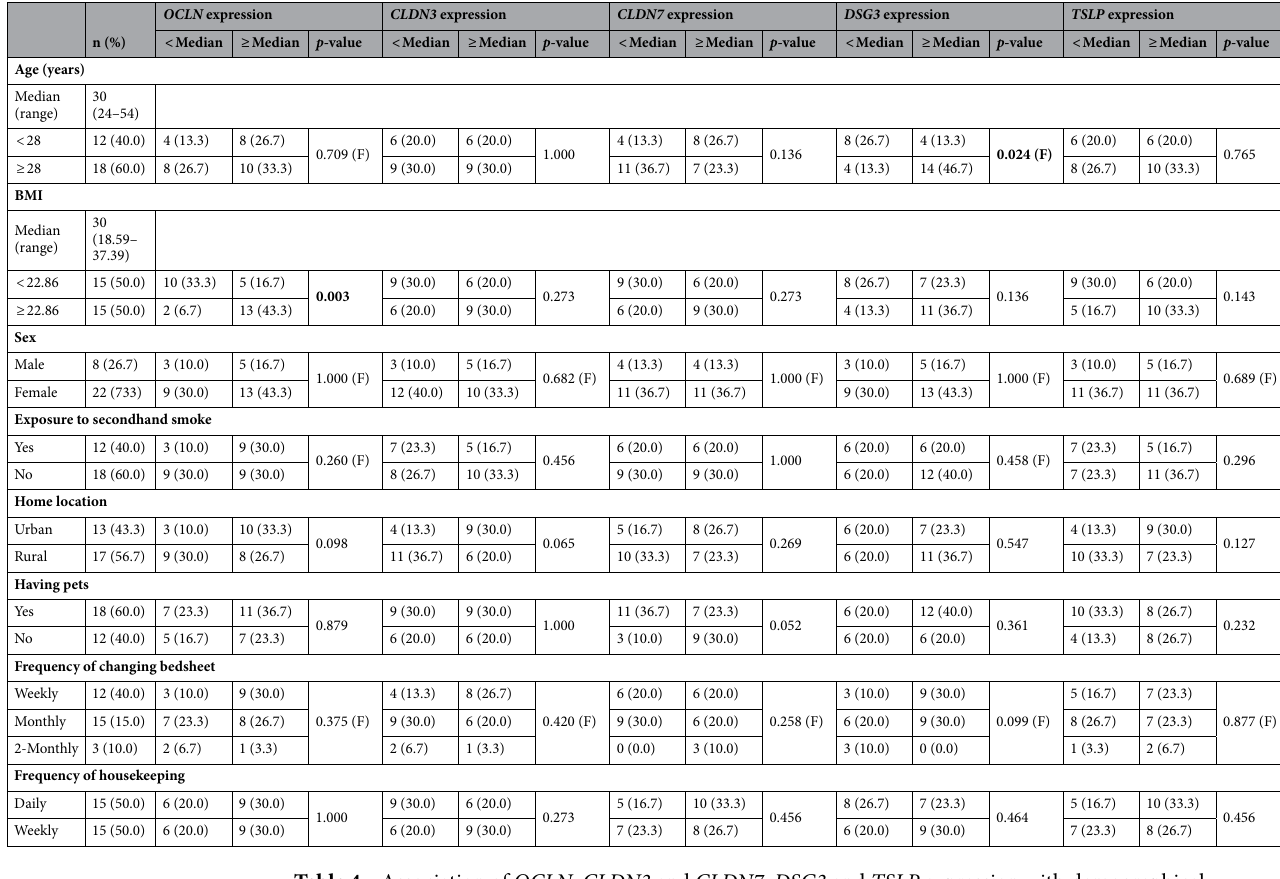
Table 4. Association of OCLN, CLDN3 and CLDN7, DSG3 and TSLP expression with demographical parameters of non-allergic individuals (n = 30). p < 0.05 shown in bold. Abbreviation: AR, allergic